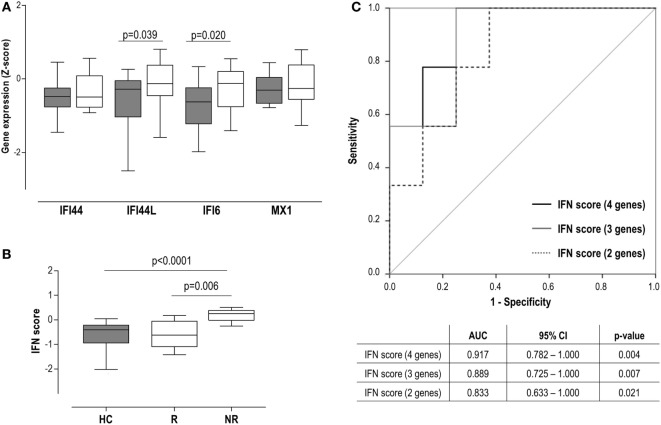
Interferon (IFN) signature as a biomarker of clinical outcome in very early rheumatoid arthritis (VERA) patients. (A) Analysis of the individual IFN-responding genes expression in VERA patients (white boxes) compared to healthy control (HC) (gray boxes). (B) Differences in the IFN score among HC and rheumatoid arthritis patients classified as responders (R) or non-responders (NRs) according to European league against rheumatism criteria after 6 months. Boxes represent 25th and 75th percentiles, whereas whiskers represent minimum and maximum values. Statistical analyses were performed by Kruskal–Wallis with Dunn–Bonferroni tests for multiple comparisons. P values correspond to those obtained in the multiple comparisons tests. (C) Area under the curve (AUC) receiving operator characteristic analysis of the IFN score to predict response at 12 months. AUCs, 95% confidence intervals (CIs), and P values are shown in the table for the IFN score: four genes [IFN-induced protein 44 (IFI44), IFN-induced protein 44 like (IFI44L), IFN alpha inducible protein 6 (IFI6), and MX dynamin-like GTPase 1 (MX1)], three genes (IFI44L, IFI6, and MX1), and two genes (IFI44L and IFI6).